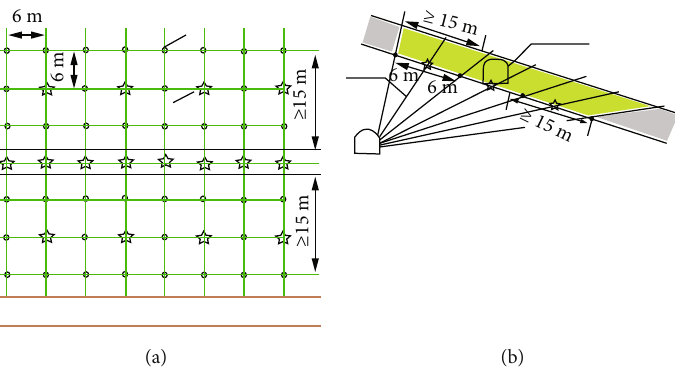
Figure 4: The layout of hydraulic perforation and hydraulic fracturing drilling. (a) The whole and (b) the local. Table 1: Physical and mechanical